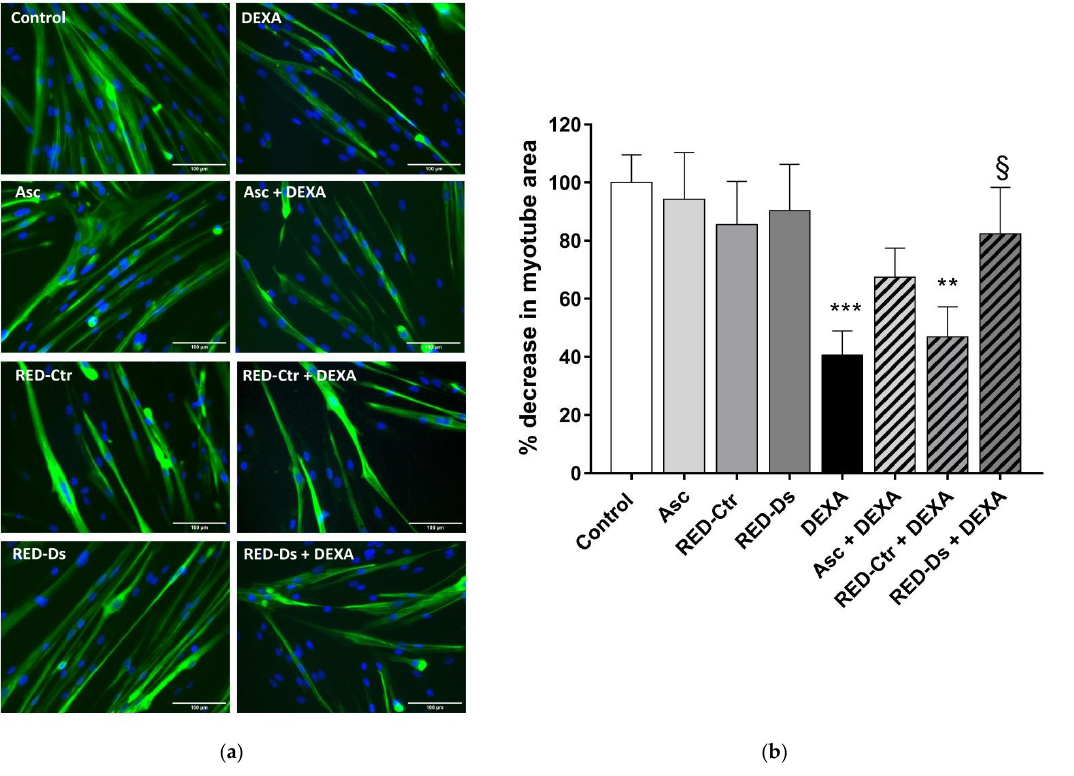
Figure 6. Tomato peel extract effect on myotube atrophy. ( a ) Representative images of differentiated myotubes (MYH2-positive cells (green), with Hoechst-labeled nuclei in blue) after 48 h of treatment with 50 µM DEXA or 5 µg/mL TPC tomato peel extracts (RED) of plants grown in normal (Ctr) or drought stress (Ds) conditions. Ascorbic acid (Asc) was used as positive control. All images at ×20 magnification; scale bar = 100 microns. ( b ) Plot shows the percent decrease, from untreated cultures, in myotube area at each treatment condition. Data represent means ± SEM, n = 10. ** p < 0.005 and *** p < 0.001 vs. untreated cell (control); § p < 0.05 vs. DEXA using one-way ANOVA.